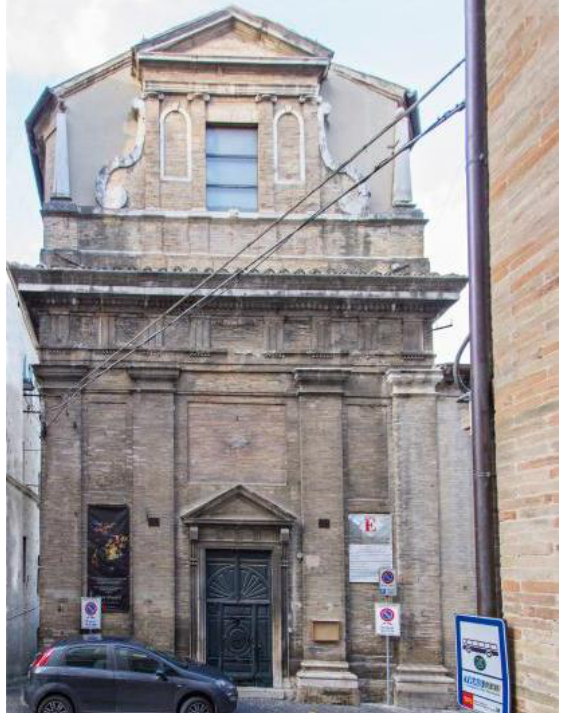
Figure 1. Main facade of the "Chiesa della Pietà" (by Onori F.)